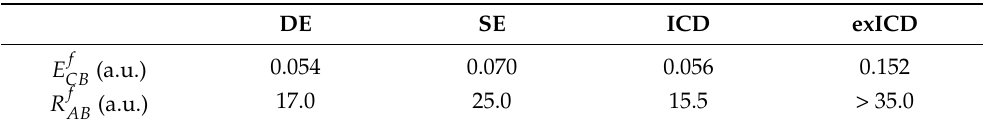
Table 2. Barrier energies E f and minimal distances R f from which the kinetic energy of electron CB AB B (for exICD A ) drops below E f are given for the effective Coulomb barriers resulting from final f CB electron configuration of the DE, SE, regular ICD, and exICD process.